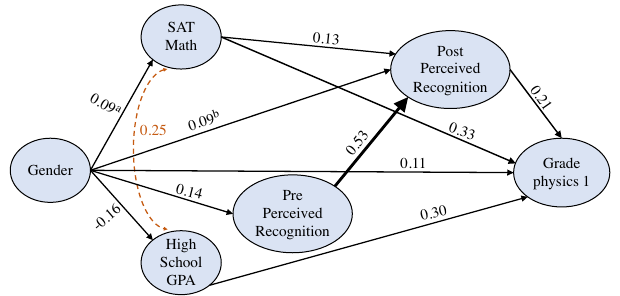
FIG. 2. Result of the path analysis part of the SEM between gender and physics 1 grade through students ’ perceived recog- nition. The line thickness indicates the relative magnitude of β values. The dashed line indicates covariances between constructs. All p values are indicated by no superscript for p < 0 . 001 , superscript “ a ” for p ¼ 0 . 021 , and superscript “ b ” for p ¼ 0 . 004